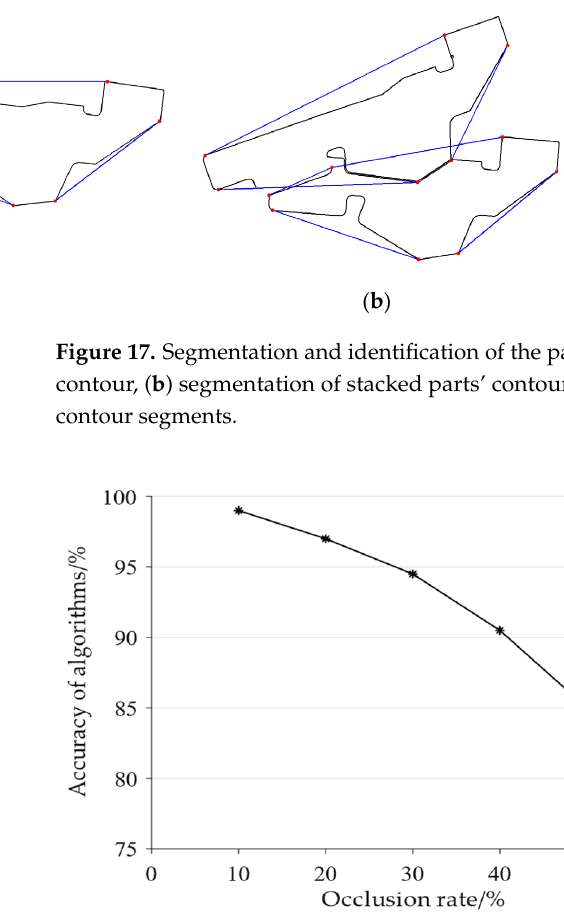
Figure 18. Accuracy of the identification algorithm at different occlusion rates.